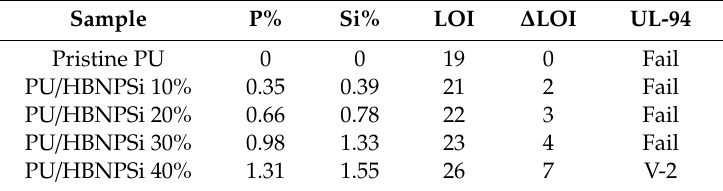
Figure 9. E ff ect of various HBPSi contents on the limiting oxygen index (LOI) of PU / HBNPSi hybrid. Figure 9. Effect of various HBPSi contents on the limiting oxygen index (LOI) of PU/HBNPSi hybrid. Table 2. The flame retardance of PU / HBNPSi hybrid by LOI Table 2. The flame retardance of PU/HBNPSi hybrid by LOI values.